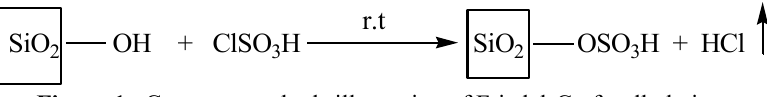
Figure 1. Common methods illustration of Friedel-Crafts